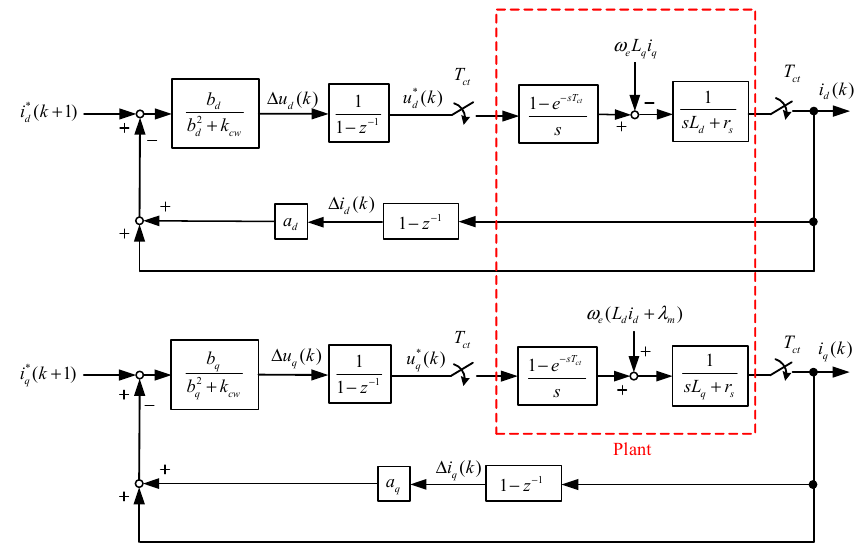
Figure 4. Block diagram of the predictive current-loop control.